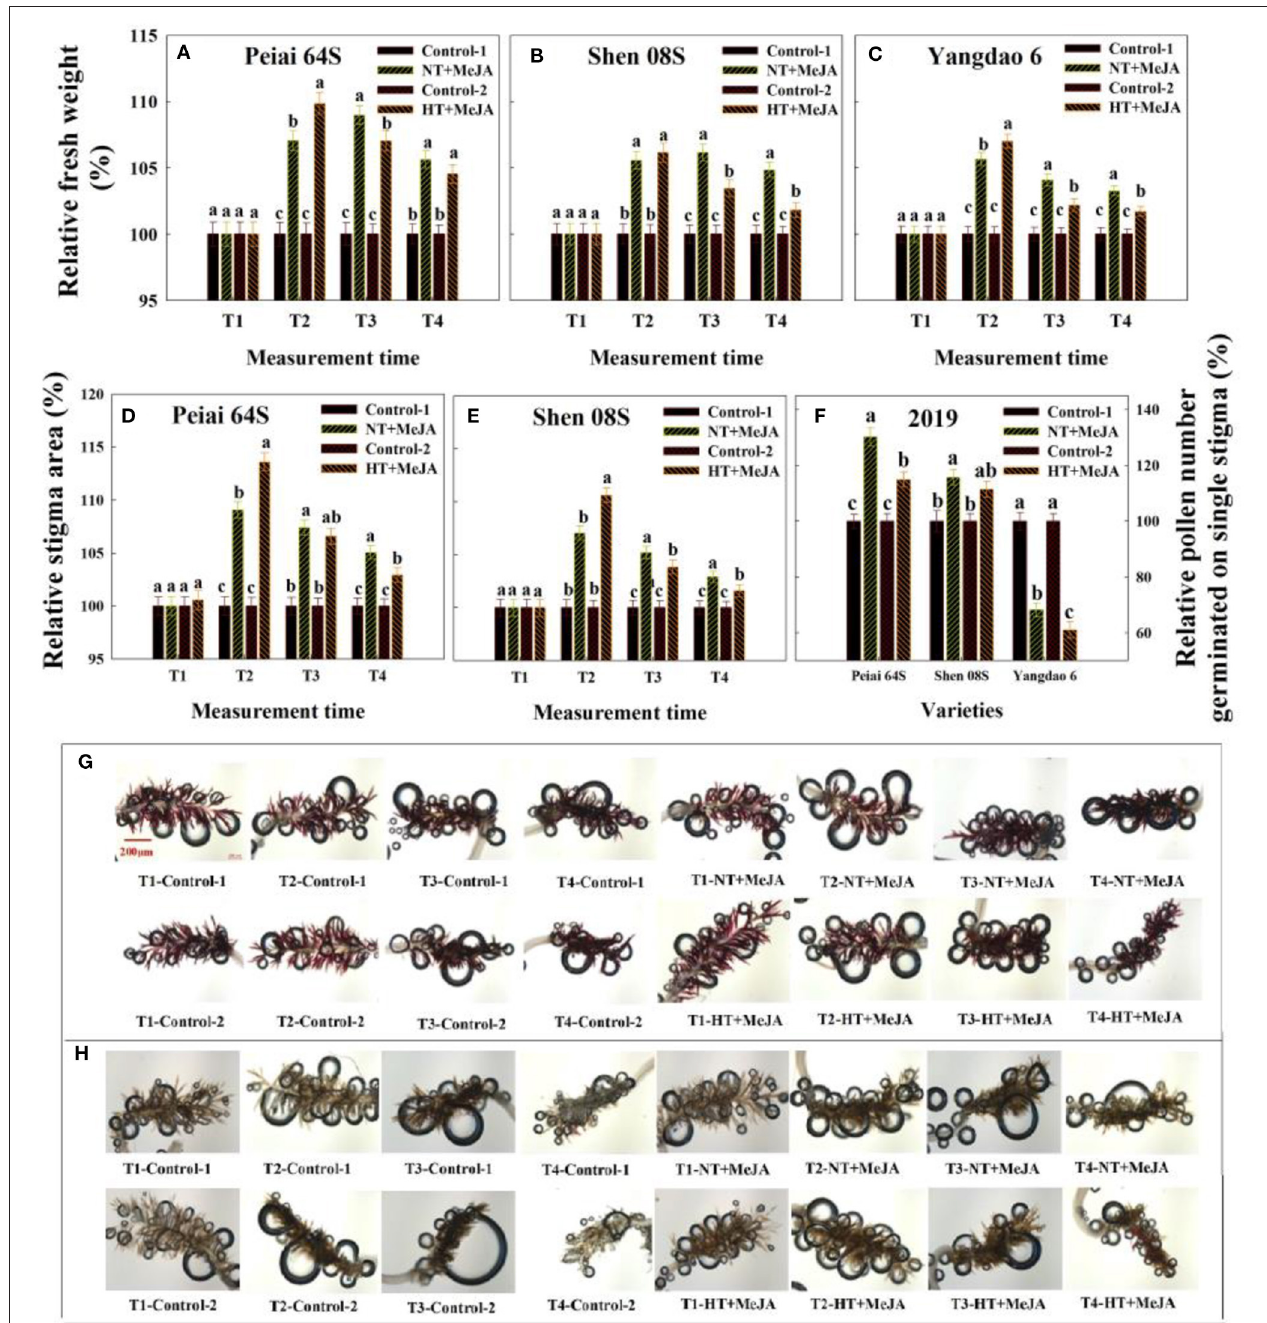
FIGURE 6 | Effect of MeJA application on the stigma fresh weight (A–C) , stigma area (D,E) , pollen number germinated on the stigma (F) , and stigma receptivity (G,H) subjected to high-temperature stress during anthesis. Control-1 and Control-2 indicate spraying water under normal temperature (NT) and spraying water under high temperature (HT), respectively. NT + MeJA and HT + MeJA represent spraying MeJA under NT and spraying MeJA under HT, respectively. T1: 12:00h on the first day during the temperature treatment; T2: 14:00h on the first day during the temperature treatment; T3: 14:00h on the second day during the temperature treatment; T4: 14:00h on the first day after the temperature treatment. The bars in (A–F) are SD of three biological replications. Different letters above the bars represent significant differences at the P ≤ 0.05 level within the same line and the same measurement time. The release of air bubbles in (G,H) indicates that the stigma is receptive. The more the air bubbles are, the higher the stigma receptive is. The stigmas were stained with 3% (vol/vol) H 2 O 2 solution and were taken at 50 × magnifications.